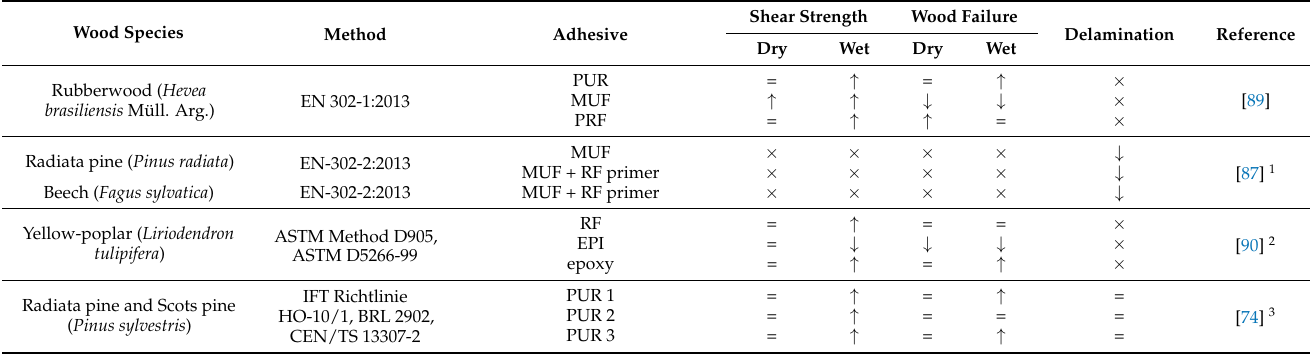
Table 3. Compared to references, the bonding performance (shear strength, wood failure percent- age, and delamination) of acetylated wood was: ( ↑ ) better; (=) equal; ( ↓ ) worse; (x) not tested; additionally, combinations are conceivable, such as when several adhesives were applied.